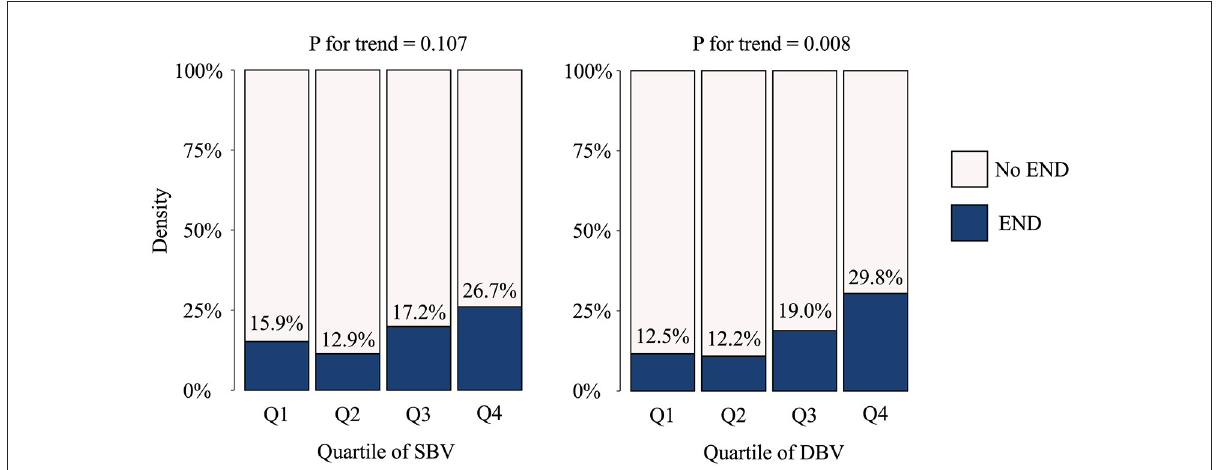
FIGURE1 Occurrence of early neurologic deterioration per blood viscosity quartile. END, early neurologic deterioration; SBV, systolic blood viscosity; DBV, diastolic blood